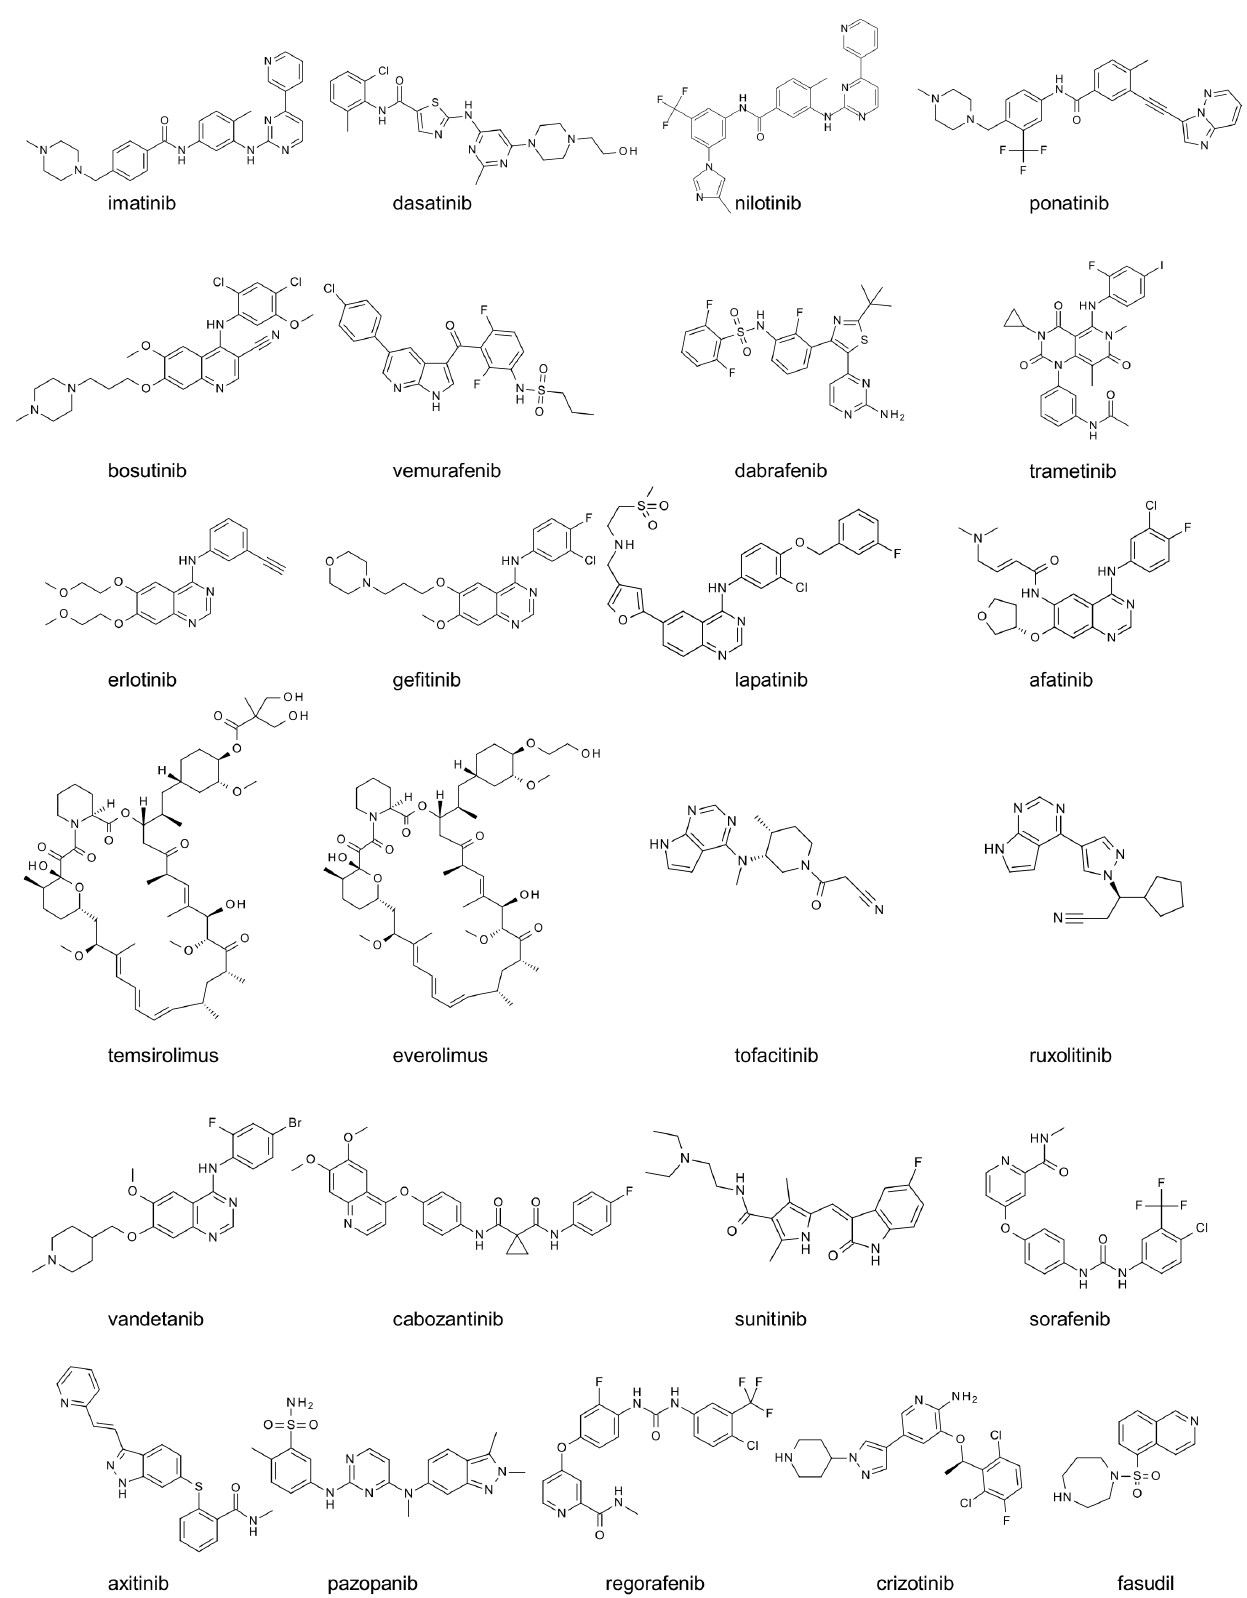
Figure 1. 2D structures of the kinase inhibitors profiled in this study. All are kinase inhibitors that were approved for clinical use at Nov. 2013.